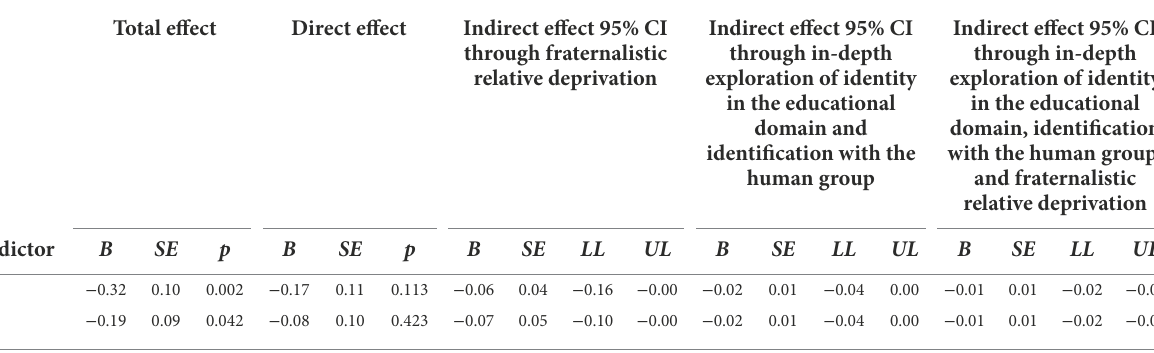
TABLE 4 Total, direct, and indirect effects of predictors of inalienability of human rights to